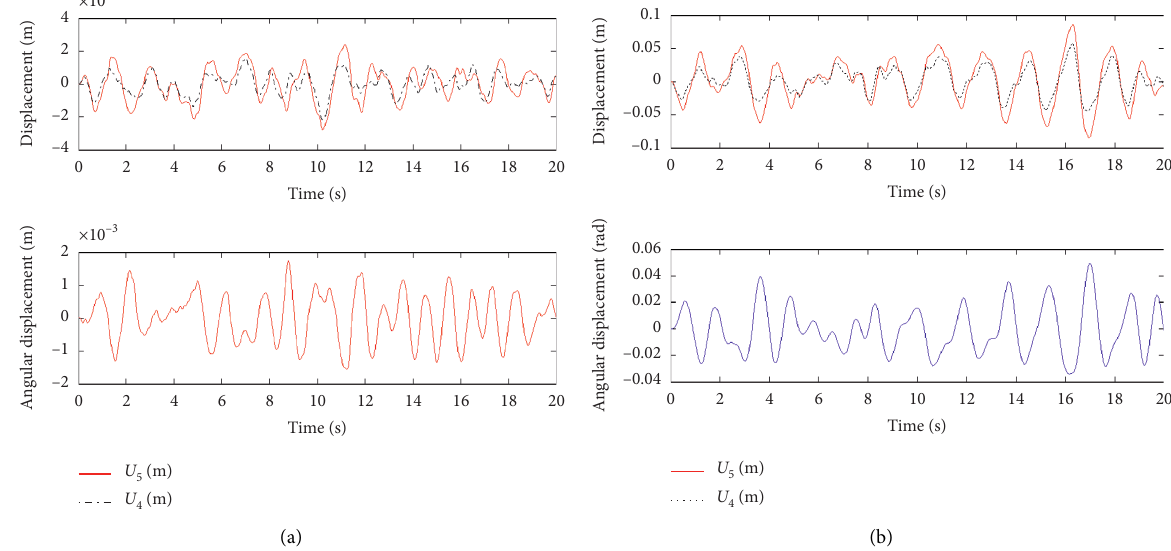
Figure 7: Responses of displacements U of half vehicle system coupling with the HNES model while the excitation is random road inputs n and the velocity of vehicle is 1.1256m/s (a) and 20m/s (b).